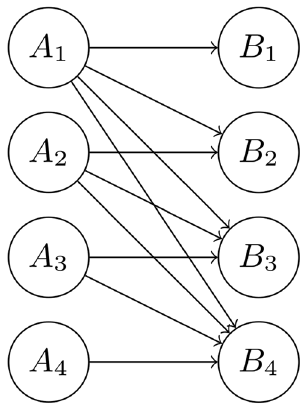
Fig. 3 Causal graph of a quantum process with causal unravelling ( A 1 , B 1 ), ( A 2 , B 2 ), ( A 3 , B 3 ), ( A 4 , B 4 ). This is a bipartite graph because inputs can be independently controlled, and every two outputs are independent conditioned on all